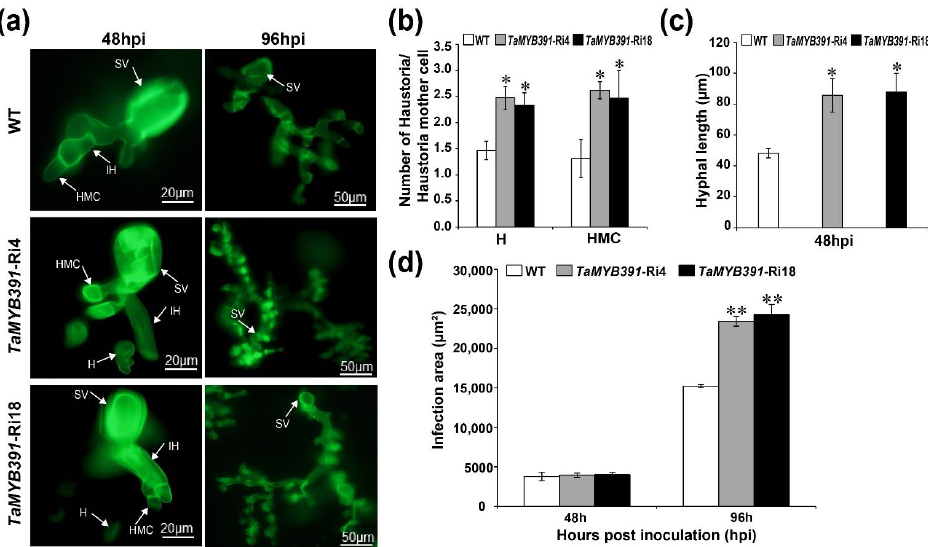
Figure 7. RNAi-mediated silencing of TaMYB391 decreased wheat resistance to avirulent Pst race CYR23 infection. ( a ) H 2 O 2 accumulation and cell death around the infection site were detected under a BX-51 microscope (Olympus, Tokyo, Japan). For H 2 O 2 burst and necrosis detection, Pst CYR23-inoculated leaves were sampled at 48 hpi. These samples were then stained with 3,3-diamino- benzidine (DAB). SV, substomatal vesicle; NC, necrotic cell. ( b ) H 2 O 2 accumulation was quantified using DP-BSW software by measuring the area where DAB is accumulated at the infection site. ( c ) The area of cell death was quantified by calculating the fluorescence area. Data were computed from three biological replications and 50 infection sites. Values represent the means ± SEs. The significant differences between TaMYB391 -RNAi and control plants are indicated by asterisks, which were estimated using Student’s t -test. *, p <0.05.